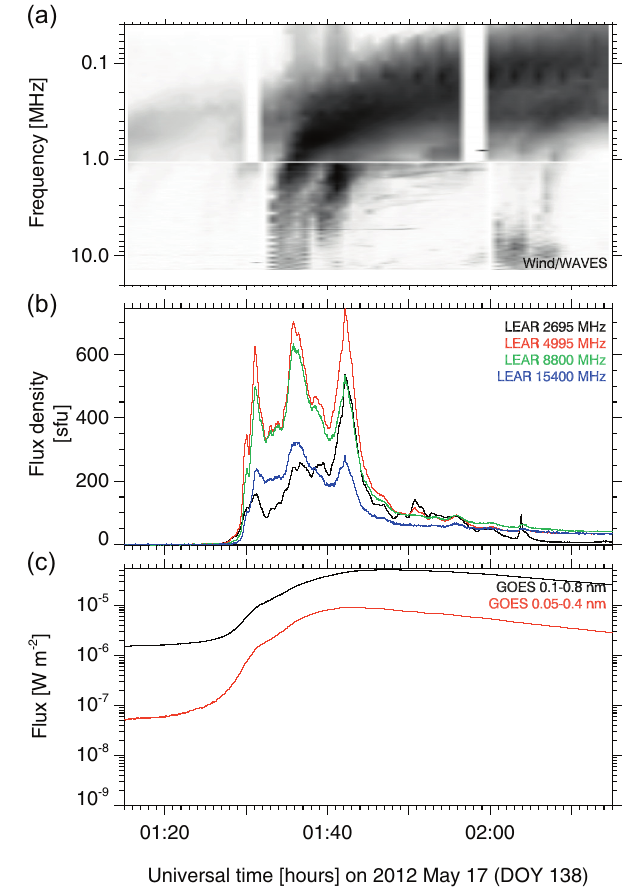
Fig. 2. Time history of the soft X-ray (c), microwave (b) and decametre-to-kilometre-wave radio emission (a) associated with the SEP event on 2012 May 17. The grey-scale plot in (a) shows a dynamic spectrum, with dark shading showing bright